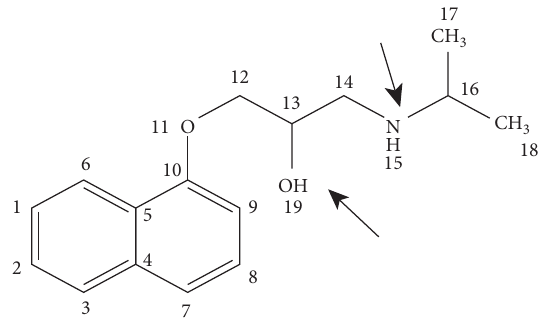
Figure 1: Chemical structure of propranolol (1-(1-methyl- ethylamino)-3-(1-naphthyloxy)propan-2-ol) and reactions at the OH group at C-13 position and N-15